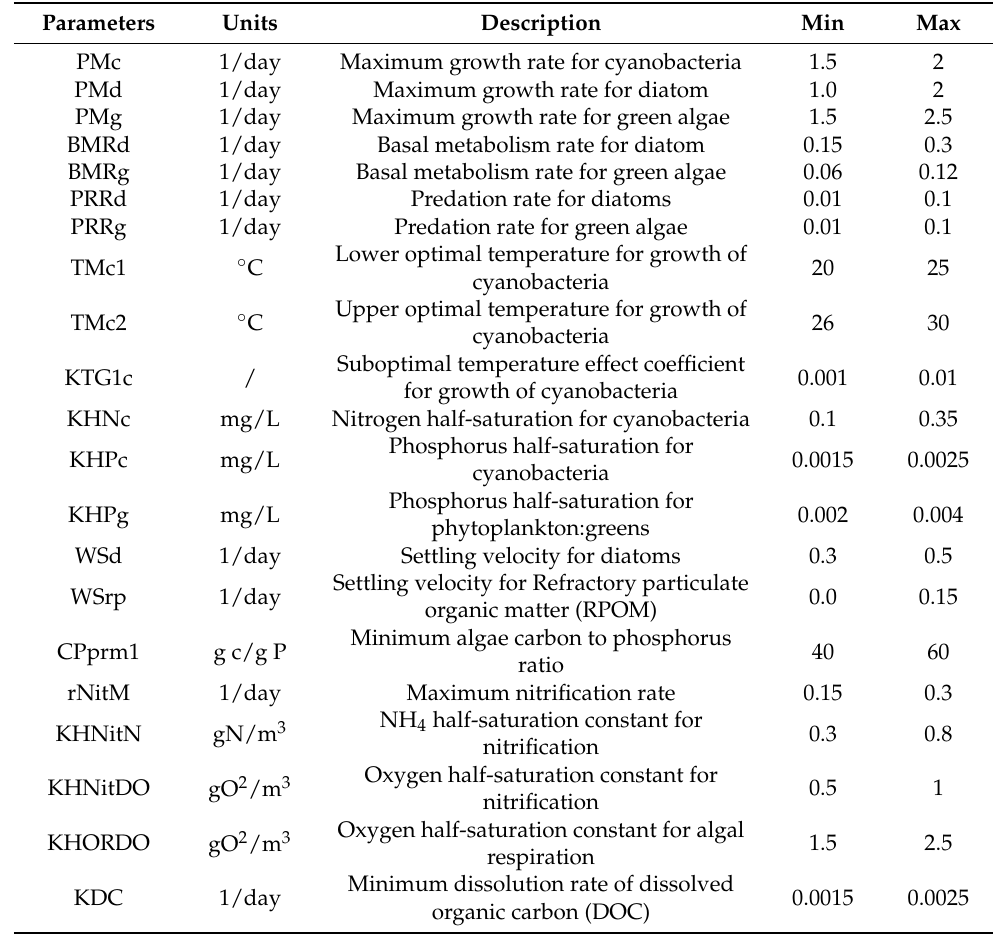
Table 1. Description of parameters for sensitivity